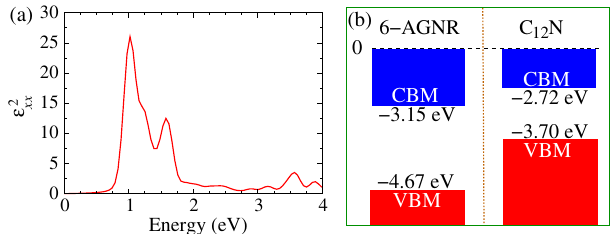
FIG. 5. (a) The computed imaginary part of the frequency- dependent dielectric function from the screened exchange HSE06 calculation. (b) The band offset between C 12 N and 6-AGNR from the HSE06 calculations. The numbers are the VBM and CBM levels with respect to the vacuum